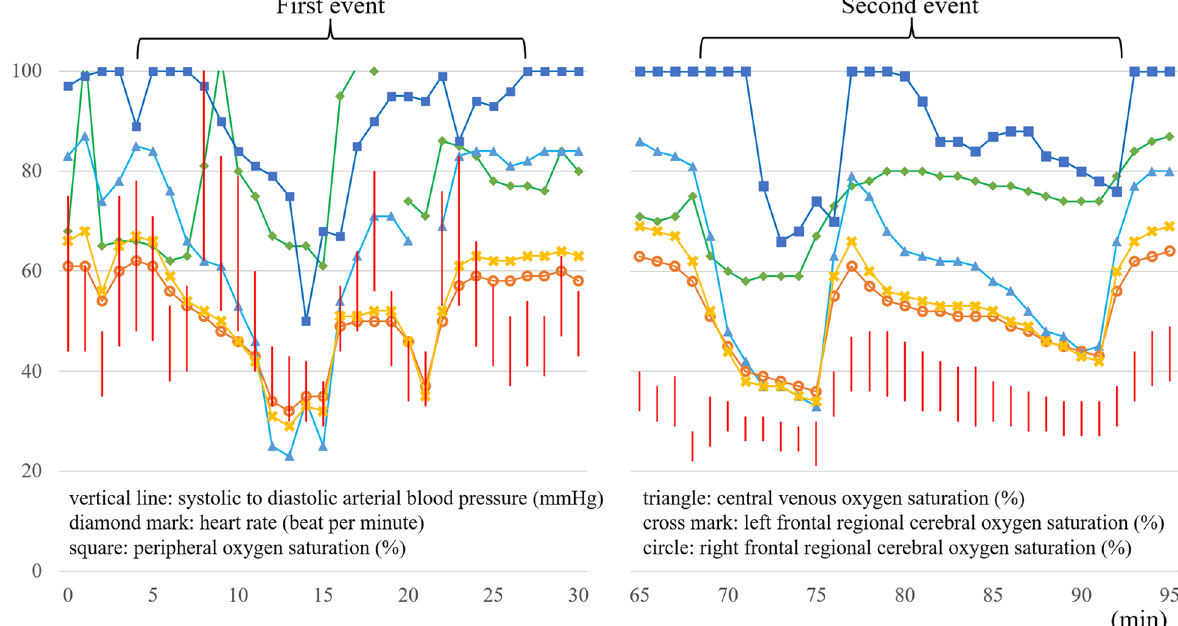
Fig. 3 Hemodynamic trends at the events. Vital trends at the time of the event with desaturation and hypotension. Five minutes before the first central venous oxygen saturation drop as zero minutes. The marks in this figure are as follows: vertical line: systolic to diastolic arterial blood pressure (mmHg), diamond mark: heart rate (beat per minute), square: peripheral oxygen saturation (%), triangle: central venous oxygen saturation (%), cross mark: left frontal regional cerebral oxygen saturation (%), circle: right frontal regional cerebral oxygen saturation